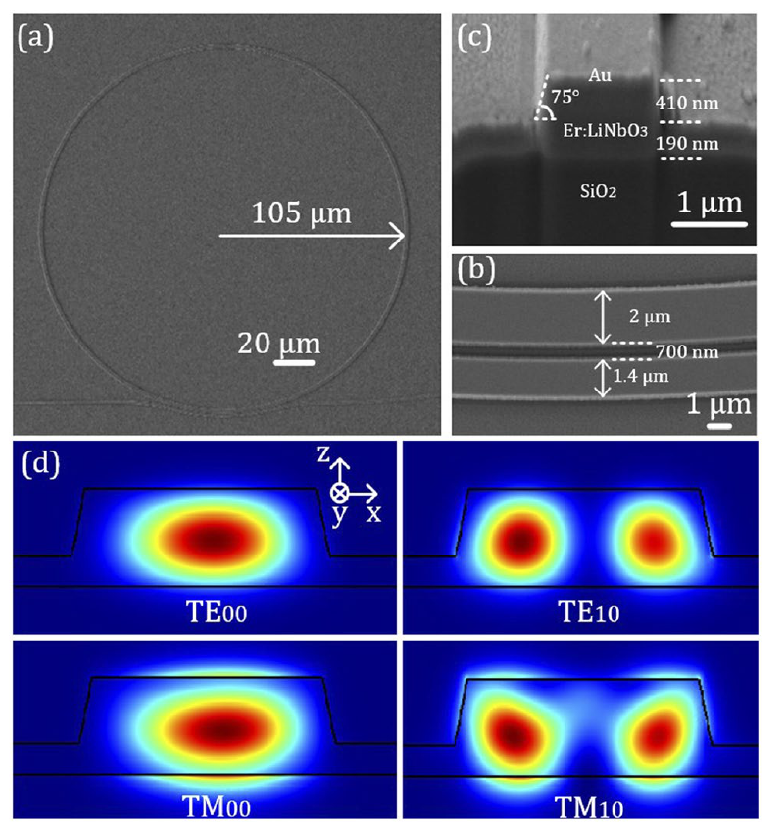
Figure 6. The SEM image of ( a ) the microring, ( b ) the pulley coupling region and ( c ) the end facet. ( d ) The four modes supported in the microring waveguide [75].